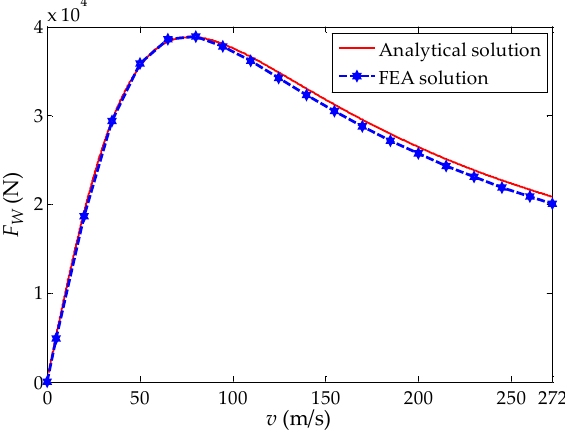
Figure 6. Eddy current braking force varying with speed.